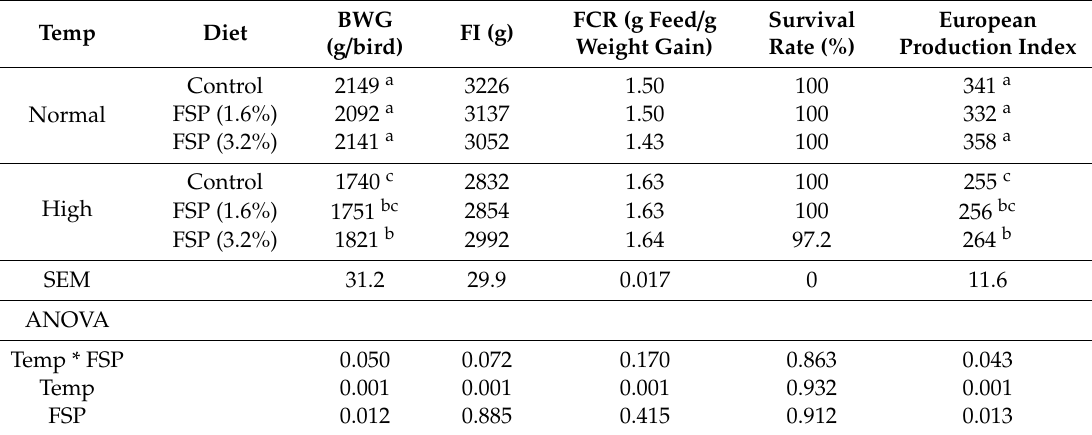
Table 2. Broiler body weight gain, feed intake, and feed conversion ratio following supplementation with fennel seed powder under thermoneutral or heat stress